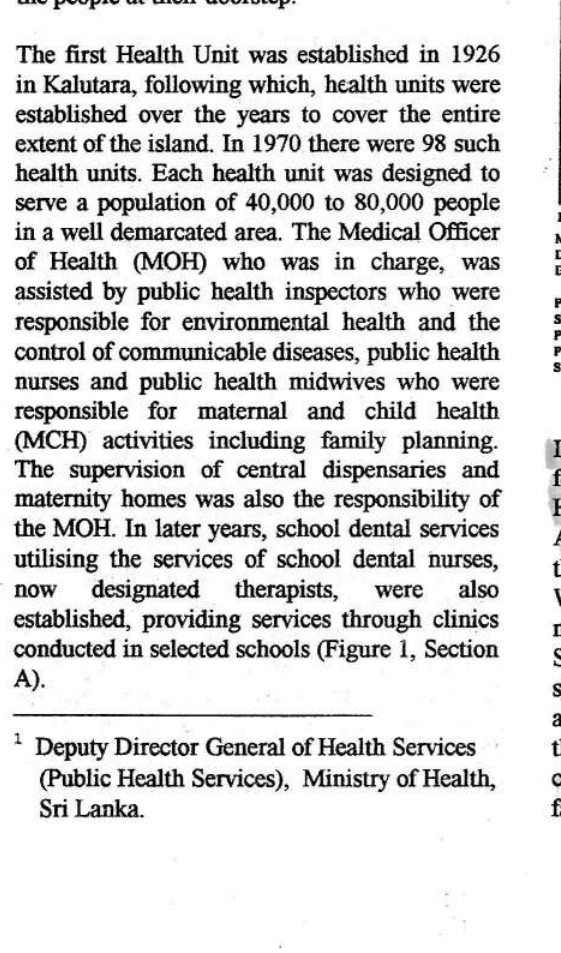
Figure l. Diagramrnatic represatation of the development of the Divisional Health Ss'trices AHealthunitryS€m B: DHO